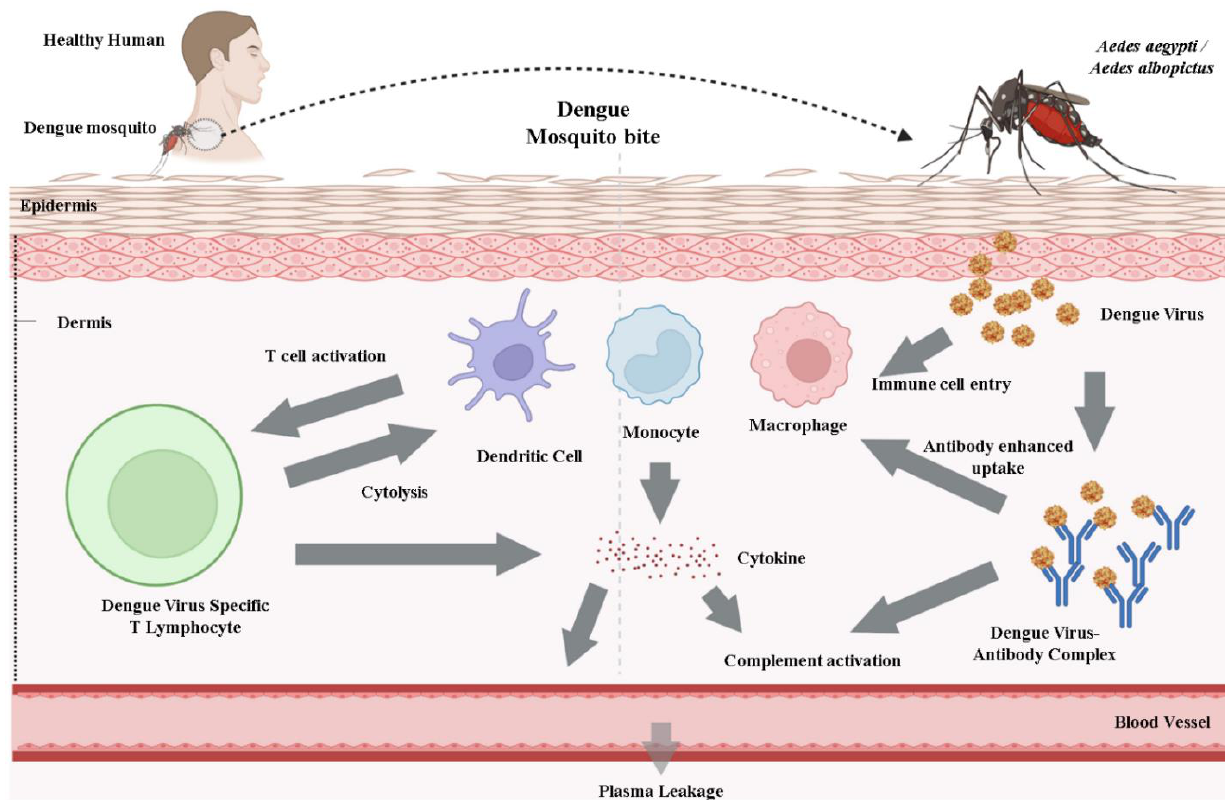
Figure 4. Pathogenesis of DENV: Released viral particles by mosquito bite may cause local immune cells to activate, primarily monocytes or dendritic cells (DCs). Natural killer (NK) cells and T cells are recruited because of a local inflammatory reaction to DENV in the skin, which enhances the death of virus-infected cells at the injection site. DENV will spread along the lymphatic pathways to draining lymph nodes, resulting in systemic infection.